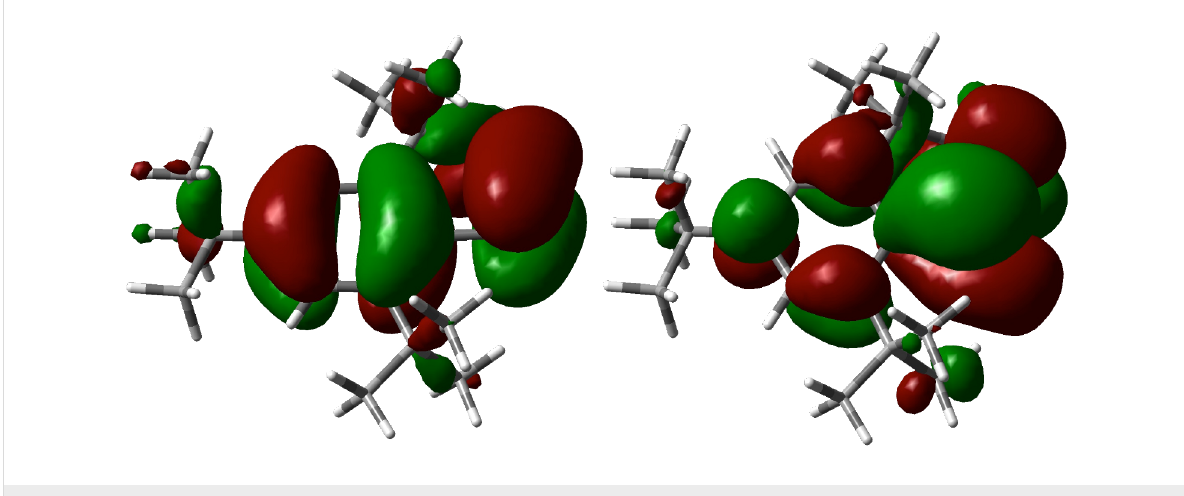
Figure 5: HOMO (left) and LUMO (right) of 2 .